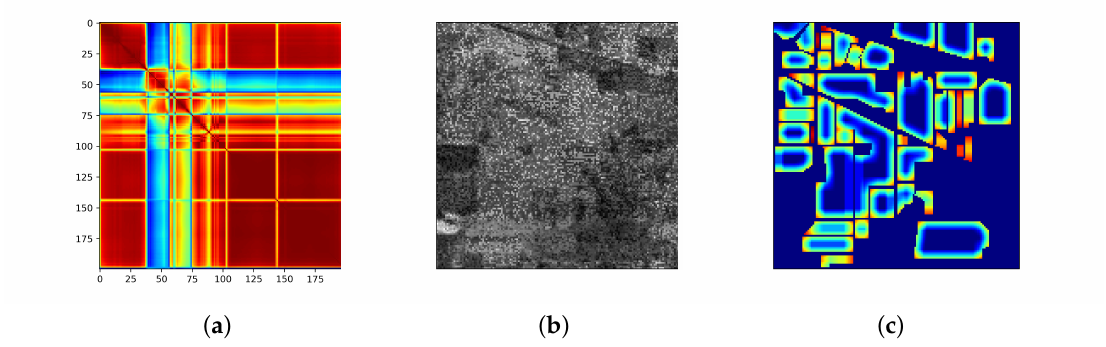
Figure 1. Data characteristics of the Indian Pines hyperspectral image: ( a ) Spectral band correlation matrix; ( b ) a noisy spectral band; and ( c ) spatial inhomogeneous pixel